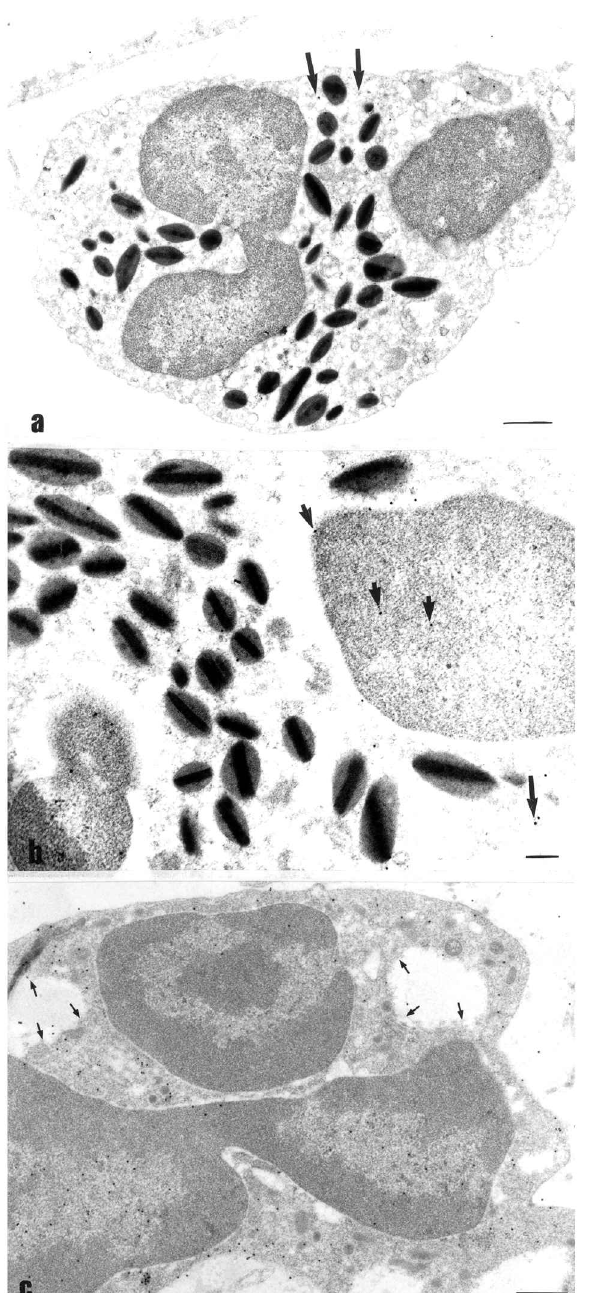
FIG. 2. Electron micrographs showing ANXA1 immunogold in extravascular eosinophils as detected by LCPS1 and LCS3 antisera. Treatment was as in Fig. 1. Sections were stained with a polyclonal sheep serum raised against the specific ANXA1 N-terminus (termed LCPS1) or with a polyclonal sheep serum raised against full-length human ANXA1 (termed LCS3). (A) LCPS1 staining for ANXA1 shows a significant proportion in the cytosol (arrows) and in granules. (B) Similar but more intense immunostaining with LCS3, with arrows highlighting gold particles in the cytosol and nucleus. (C) Extravasated neutrophils were greatly activated as indicated by the presence of large vacuoles in the cytosol (arrows). LCS3 produced an intense degree of immunor- eactivity both in the cytosol and the nucleus. Bars: (A) and (C) 0.5 m m, (B) 0.2 m m.